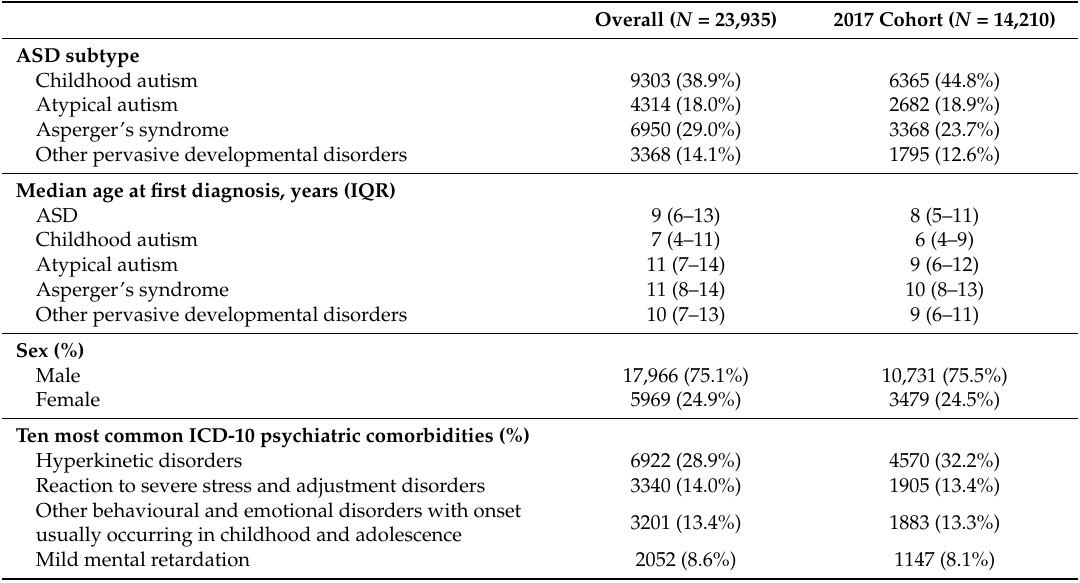
Table 1. Baseline characteristics of the study